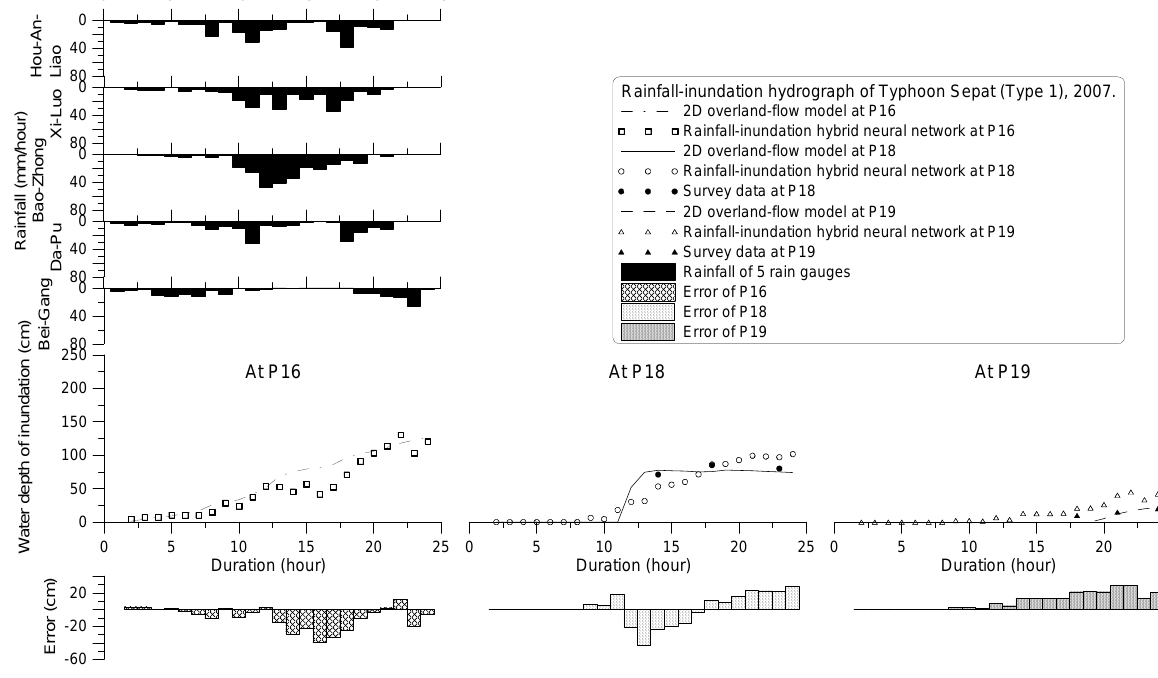
Fig. 10. The rainfall-inundation hydrograph of Typhoon Sepat (Type 1) in 2007.